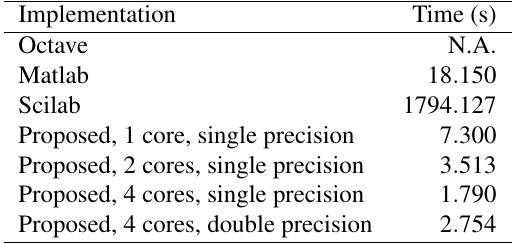
Table 2. Comparative results in composing 2 full 1000 × 1000